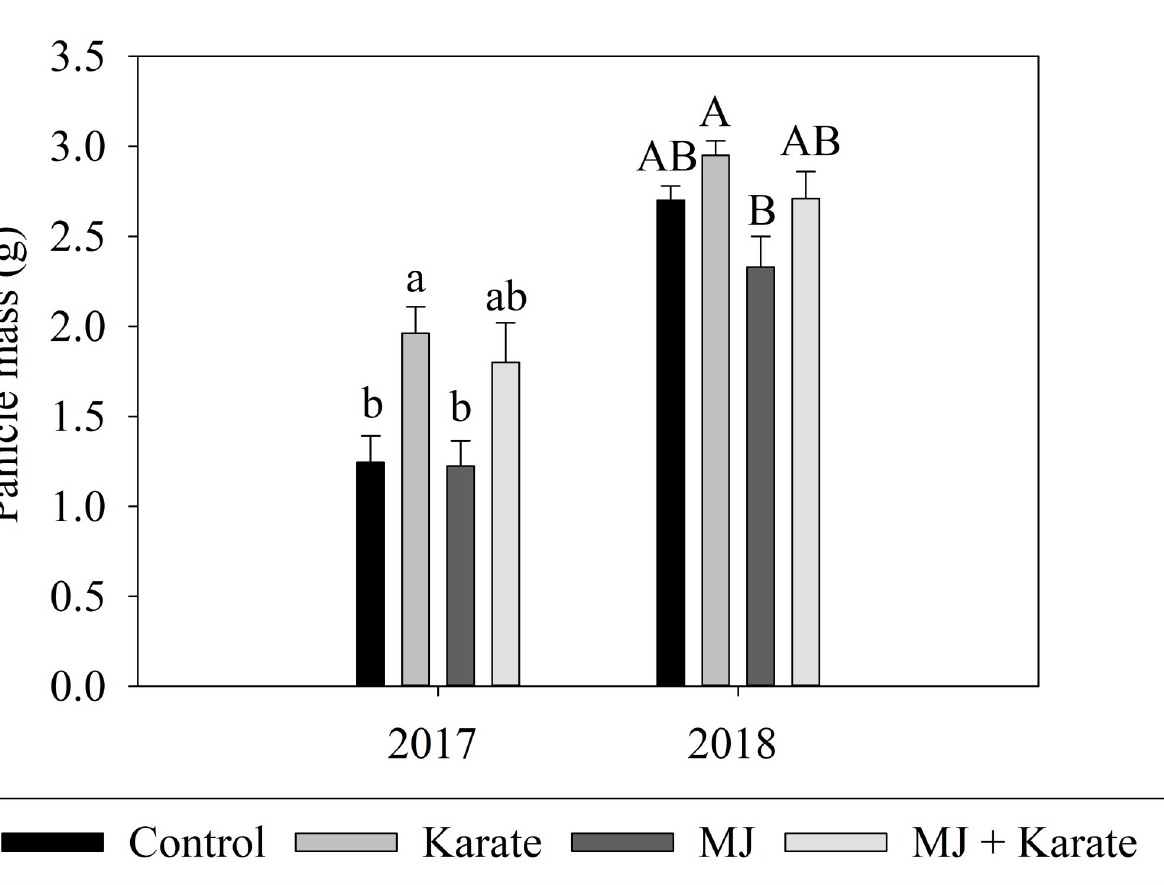
Fig 6. Effects of factorial combinations of methyl jasmonate seed treatment (MJ) and application of insecticide (Karate) on individual panicle mass (grams of grain per panicle ± S.E.) in the experiments performed in 2017 and 2018. Mean panicle masses for MJ–treated (MJ), insecticide- treated (Karate), insecticide and MJ-treated (Both), and non-treated plots (Control) are shown. Bars accompanied by different letters represent means that differed significantly by Tukey’s HSD test at α <